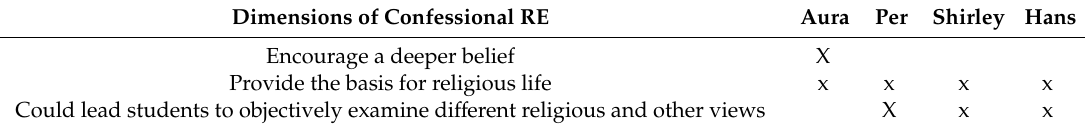
Table 2. Confessionalism according Pyysiäinen’s definition in these four narratives. Dimensions of Confessional